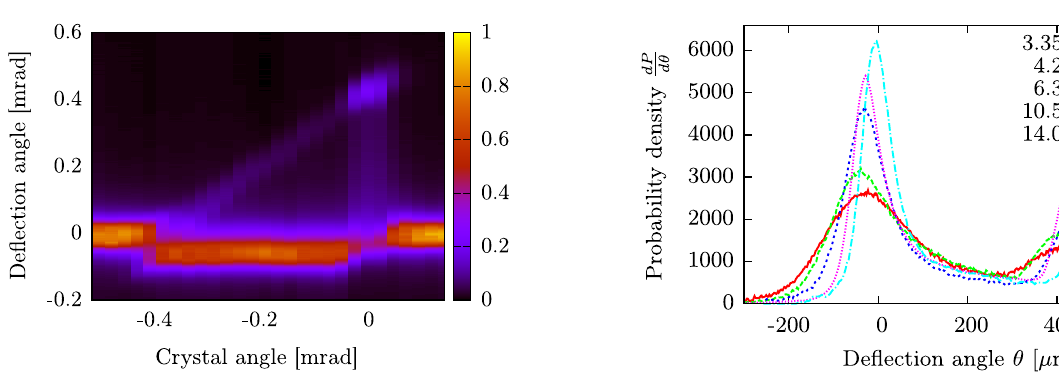
FIG. 7. The probability density relative to the maximum probability density of the deflected particles as a function of the crystal angle for the case of 10.5 GeV electrons.